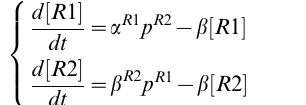
algorithm (evaluation of a parameter set), the model-data